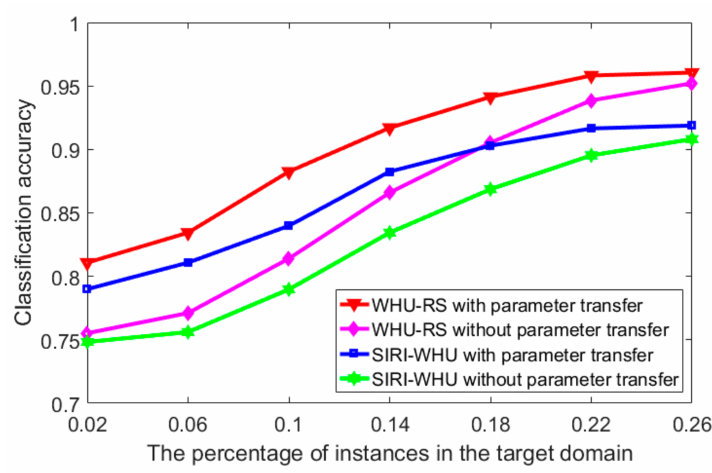
Figure 20. Effect of the percentage of instances in the target domain on classification accuracy in two datasets.